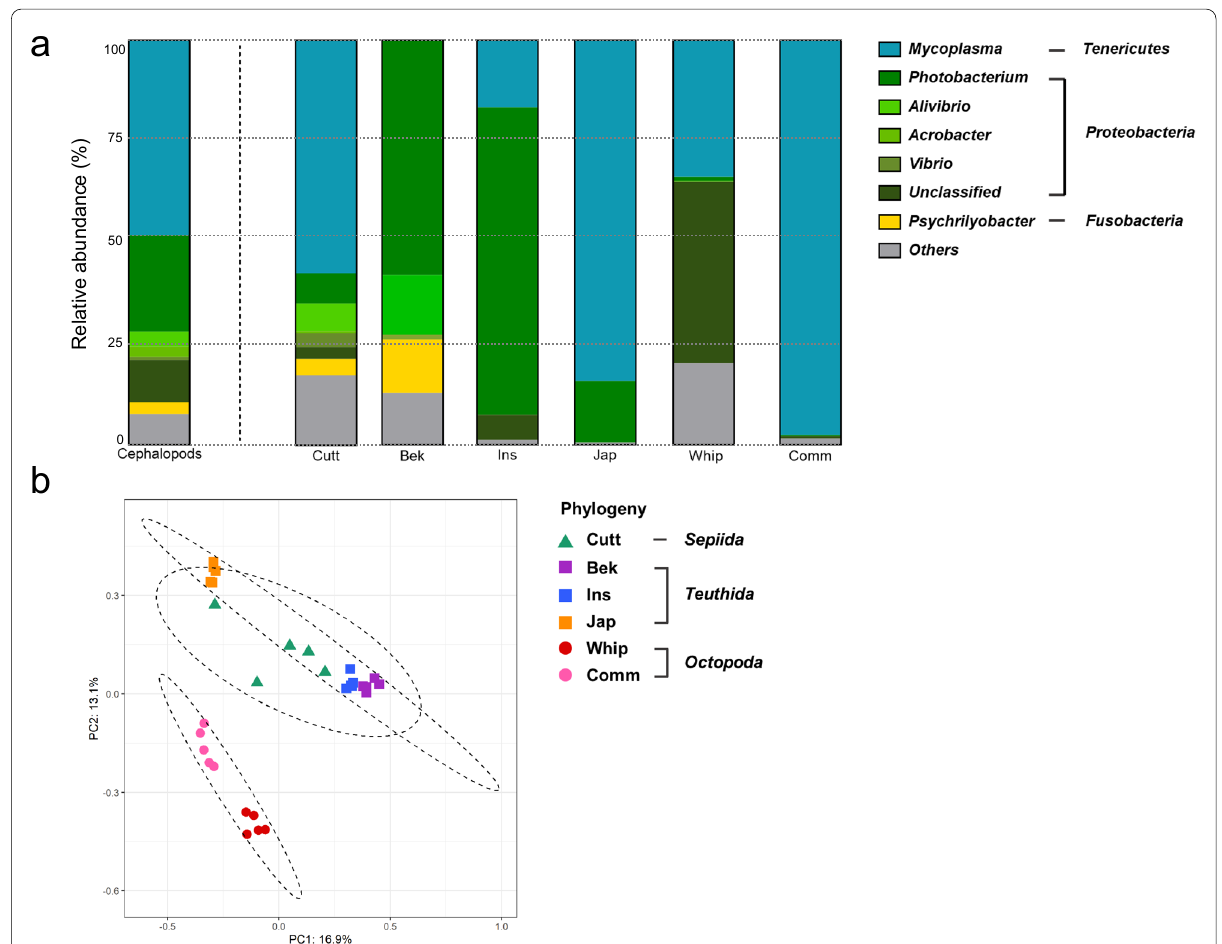
Fig. 1 Gut microbial community structure of cephalopods. a Bar charts of the relative abundance of bacterial genera in six cephalopod species and the overall gut microbial composition of cephalopods. Only genera with a relative abundance of > 0.5% are shown; those with < 0.5% are classified as “Others.” b Principal coordinates analysis (PCoA) of binary Jaccard distances between cephalopod samples. The colored dots and ellipses in PCoA represent the host cephalopod species and their orders. Abbreviations: Cutt, cuttlefish; Bek, beka squid; Ins, Inshore squid; Jap, Japanese flying squid; Whip, whiparm squid; Comm, common